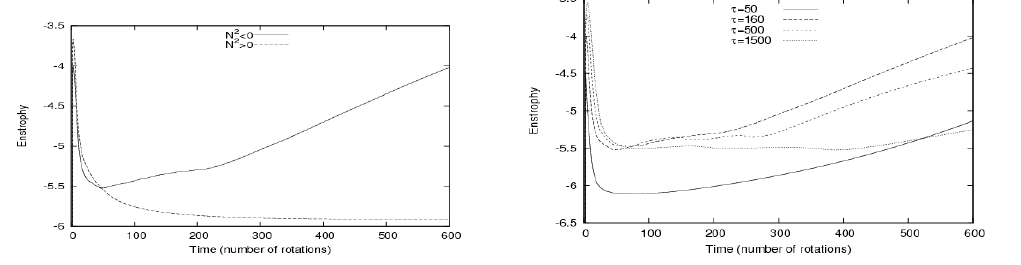
Figure 3. Evolution of the enstrophy for various cooling times.